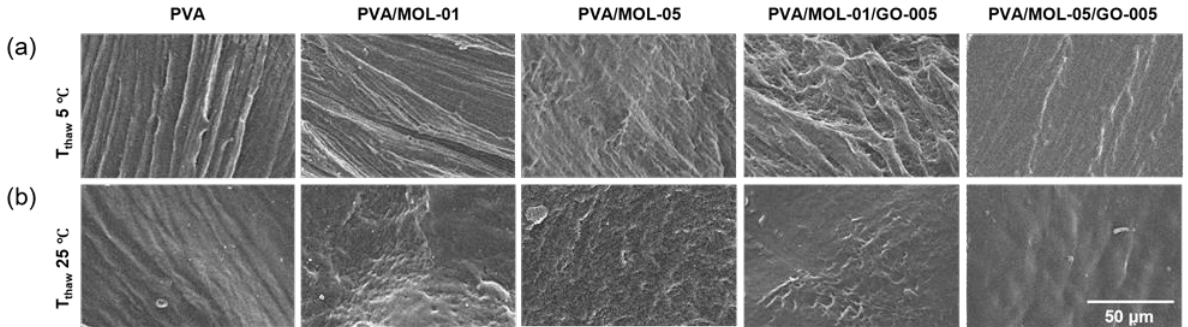
Figure 2. Surface morphology of freeze–thawed hydrogels prepared at two different thawing temperatures: ( a ) 5 °C and ( b ) 25 °C.